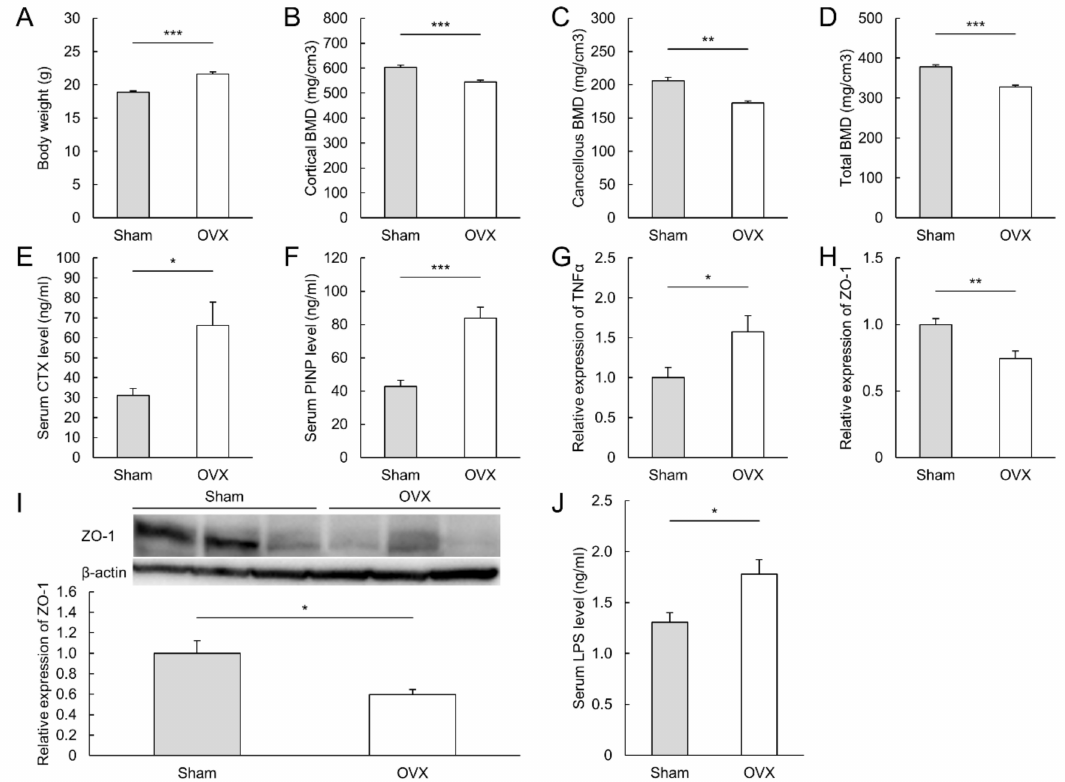
Figure 1. Bone loss and impaired colonic barrier integrity following ovariectomy. ( A – F ): Body weight, tibial bone mineral density ( B – D ), serum bone formation marker ( E ), and serum bone resorption marker ( F ) at sacrifice. ( G ); The relative expression of TNF α mRNA in colon. ( H – J ): Evaluation of colonic barrier integrity. The relative expression of ZO-1 mRNA ( H ) and ZO-1 protein ( I ) in the colon and serum LPS levels ( J ). The protein expression level of ZO-1 was normalized to that of β -actin. N = 5–10 per group. BMD: bone mineral density, CTX: C -terminal telopeptide of collagen, LPS: lipopolysaccharide, PINP: procollagen type I N -terminal propeptide, TNF α : tumor necrosis factor alpha, ZO-1: zonula occludens-1. * p < 0.05, ** p < 0.01 and *** p <